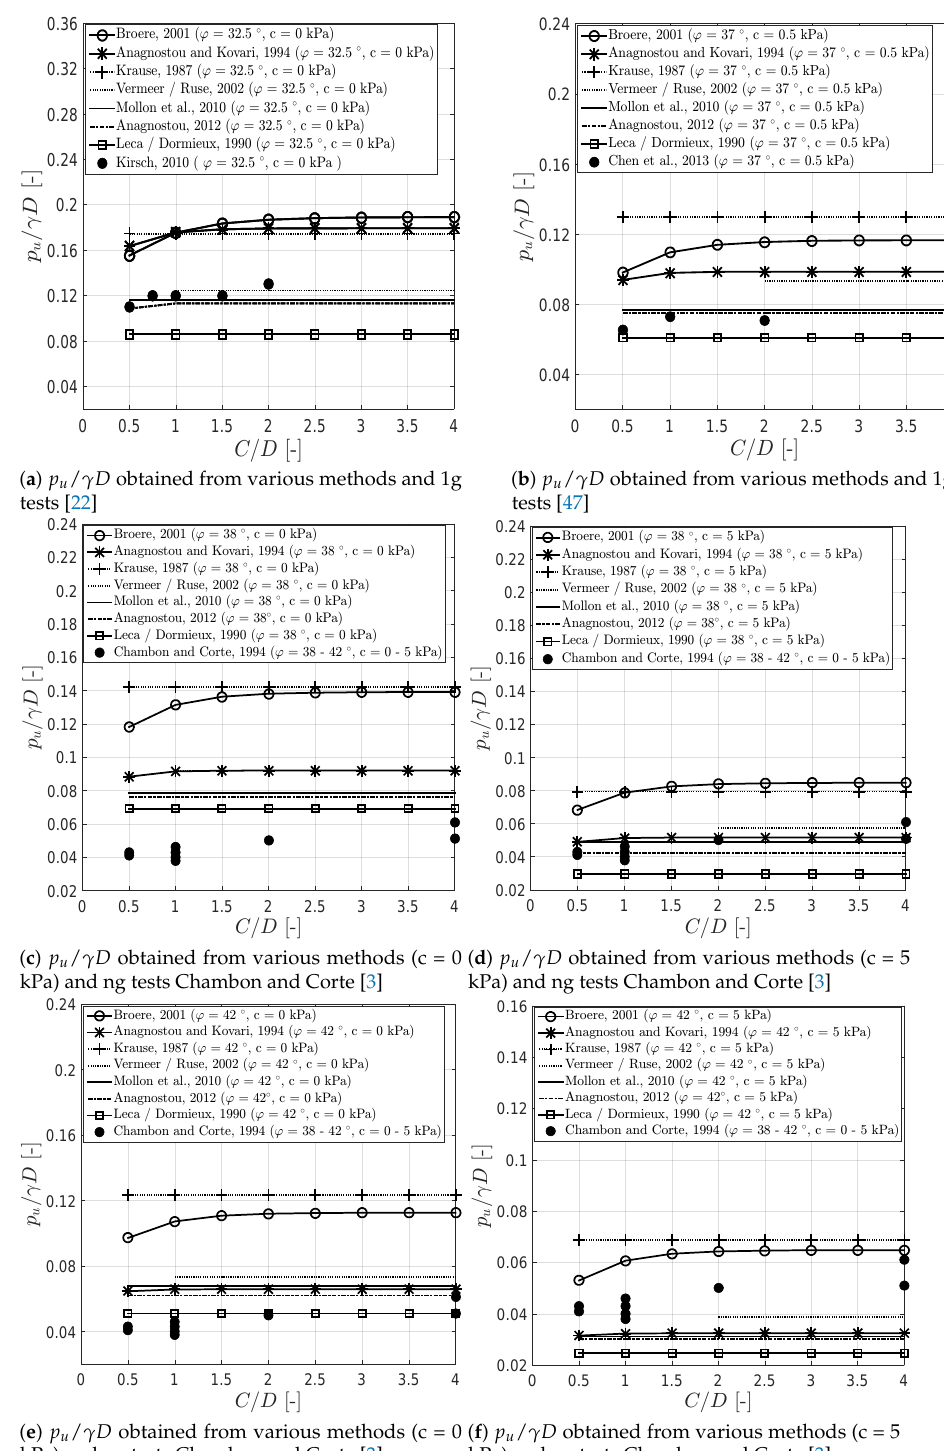
Figure 9. Comparison of p u / γ D values obtained from different methods with physical model